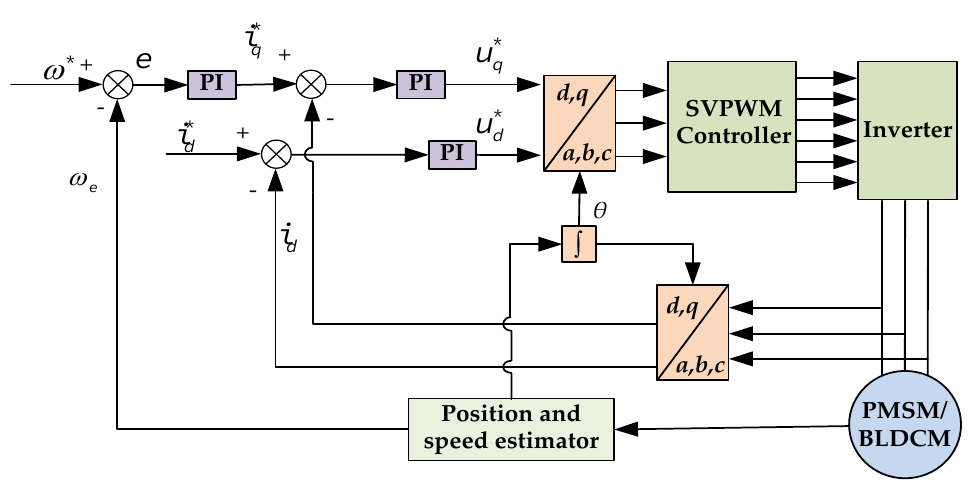
Figure 7. Block diagram of state observers method.